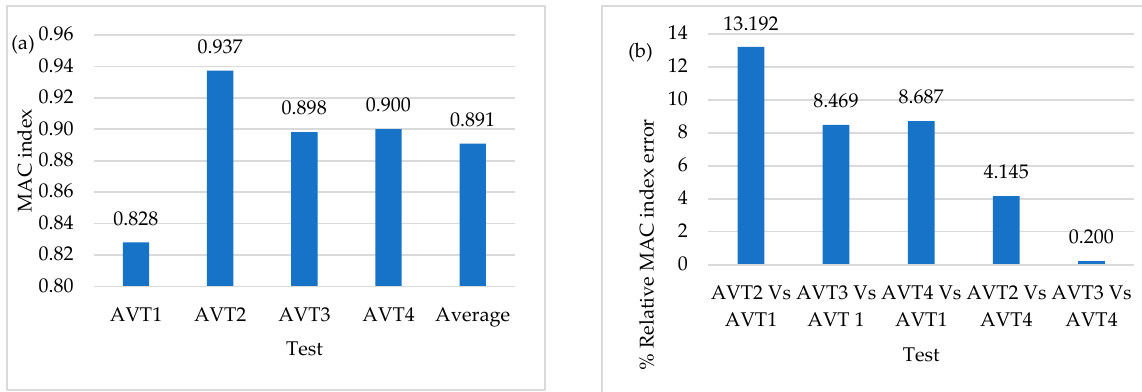
Figure 18. ( a ) Average values of MAC index of AVTs ( b ) Percentage of relative MAC index error of AVTs with full time-series length.